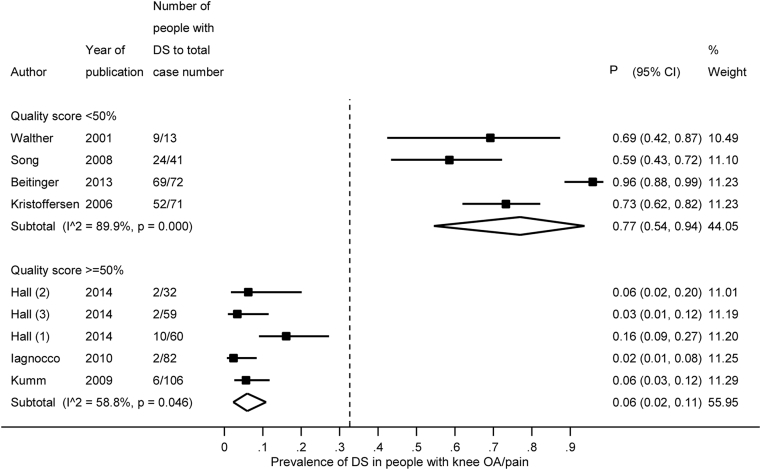
Forest plot showing the subgroup analysis by overall quality score for the prevalence of DS in people with knee OA/pain. P – prevalence rates, 95% CI – lower and upper confidence limits of the 95% confidence interval around the mean prevalence rate. The diamond in the forest plot denotes the summary prevalence and its edges the respective 95% CIs. Three groups from the study by Hall were included: (1) – people with symptomatic OA, (2) – people with radiographic OA, (3) – people with knee pain.